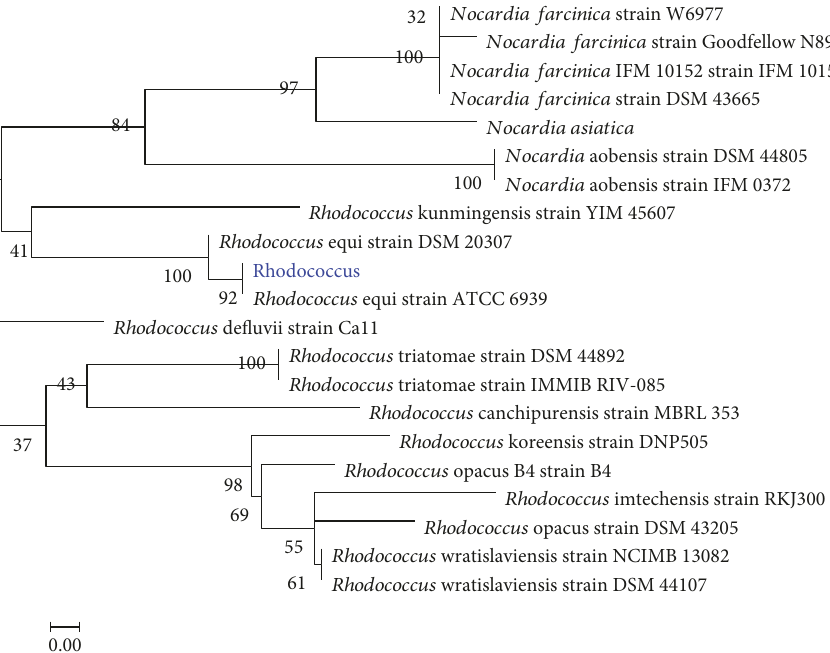
Figure 5. Through functional gene annotation and sequence